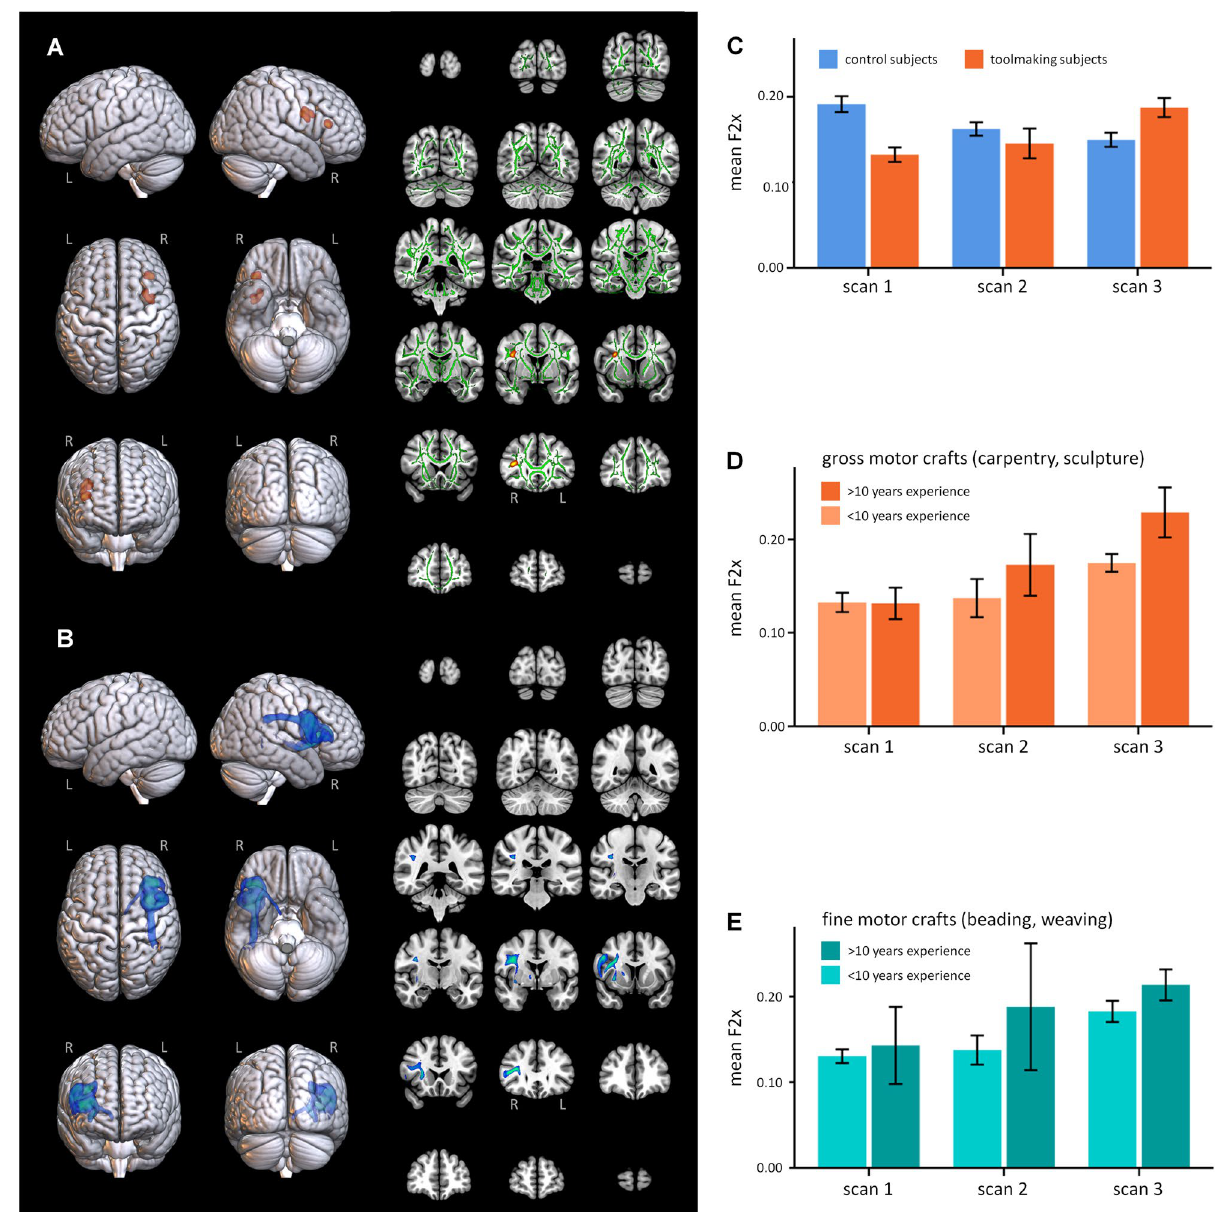
Figure 3. Neuroplastic change in the experimental group as compared to the control group. ( A ) Voxels illustrated in orange show a significantly more positive slope from scan 1 to scan 3 in the experimental group as compared to the control group in F2x (i.e., the estimated proportion of the diffusion signal that can be accounted for by the second fiber orientation after alignment of diffusion vectors across subjects). In 2D slices, the white matter skeleton is shown in green. ( B ) Probabilistic tractography from voxels showing neuroplastic change in ( A ). This is a composite image representing above-threshold connectivity in at least 67% of the participants. ( C ) Mean F2x value (i.e., the estimated proportion of the diffusion signal that can be accounted for by the second fiber orientation after alignment of diffusion vectors across subjects) at scans 1, 2, and 3 in the control and toolmaking groups. ( D ) F2x increased more rapidly in toolmaking participants with > 10 years of prior experience in gross motor crafts as compared to toolmaking participants without this prior experience, although no pairwise comparisons reached significance. ( E ) A similar pattern was visible in participants with > 10 years of prior experience with fine motor